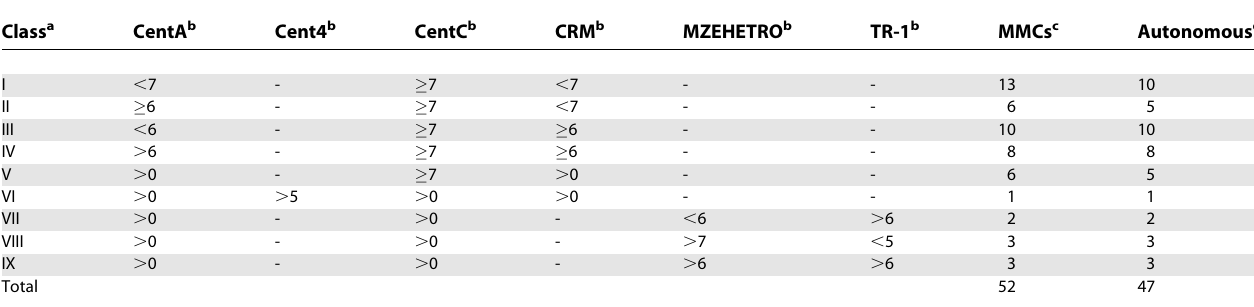
Table 1. Classification of Maize BAC Clones Containing Repetitive DNA Class a CentA